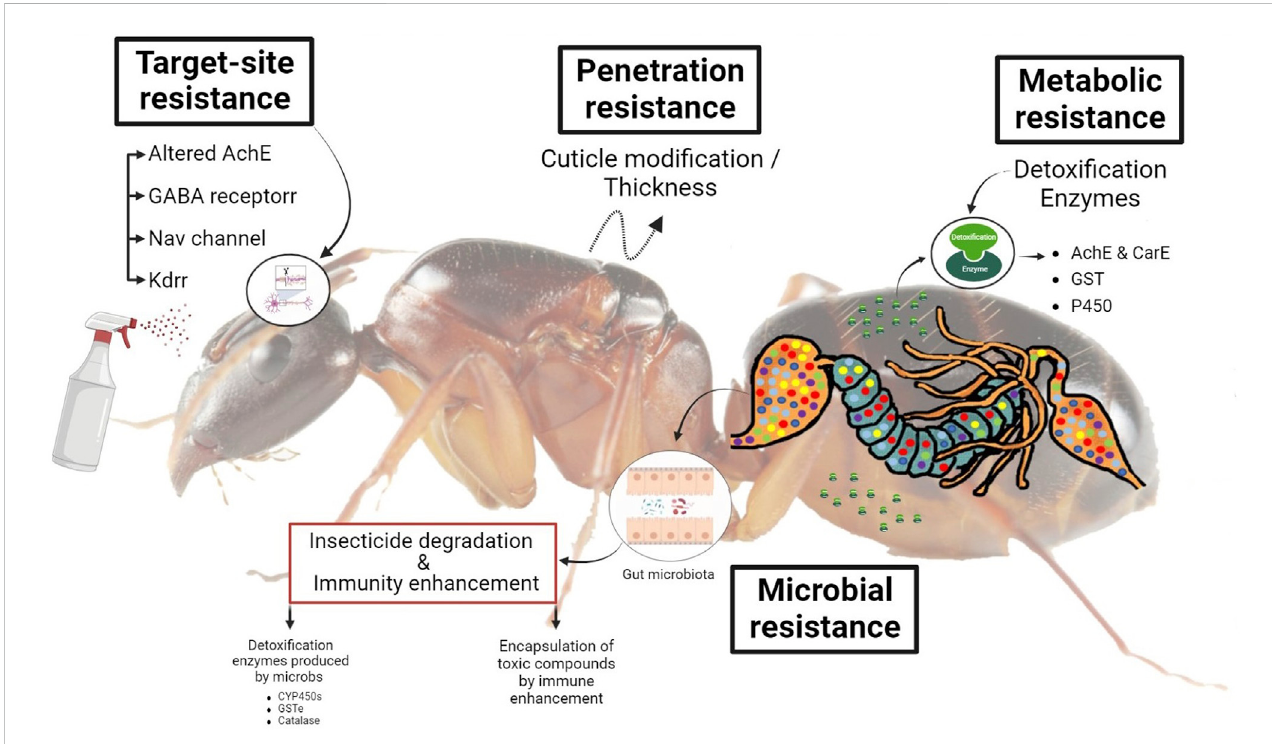
FIGURE 2 A schematic diagram represents the role of enzymes and gut microbiota in pesticide detoxi fi cation in invasive ants.